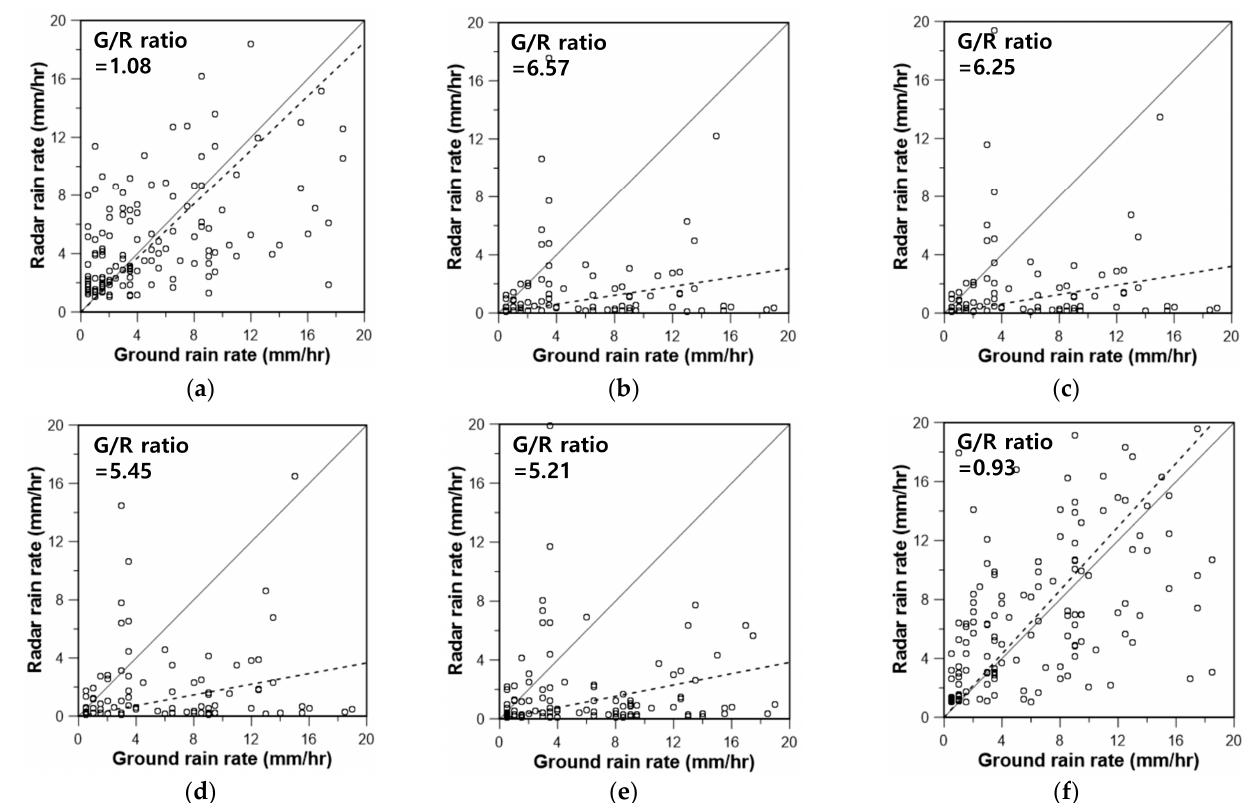
Figure 9. Comparison of the ground rain rate and radar rain rate at the Shinpo rain gauge station (No. 936) by applying the parameters of radar rain rate estimator in this study (EKF and LSM) and several other studies: ( a ) EKF, ( b ) Chandrasekar and Bringi (1988) [41], ( c ) Chandrasekar et al. (1990) [43], ( d ) Lee (2006) [48], ( e ) Kwon et al. (2015) [51], ( f ) LSM.